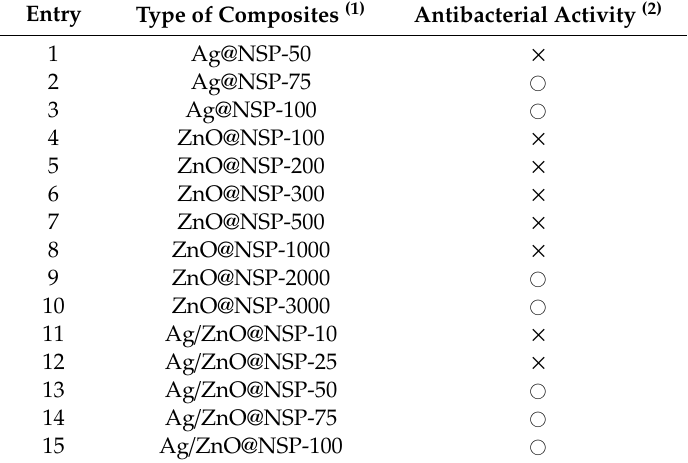
Table 2. Antibacterial activity of the composites based on UAC50 / TPGDA ( w / w = 70 / 30) resins